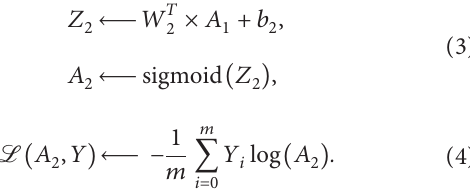
Figure 3. The forward propagation and backward prop- agation are performed for a number of iterations, until the cost cannot be further decreased. The pseudocode of the algorithm of deep learning for absenteeism prediction is